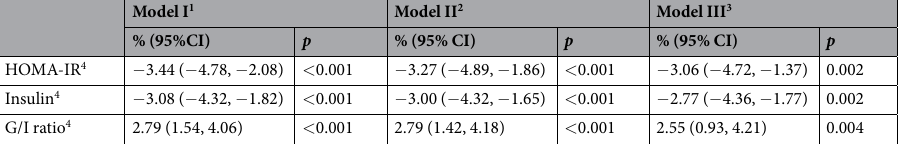
Table 2. Percentage Change (95%CI) in Insulin Resistance/Sensitivity Associated with a 25% Increase in Serum Folate Concentrations among U.S. Nondiabetic Adults, NHANES 2011–2012 1 Model I: Adjusted for age, gender (M/F), race/ethnicity (non-Hispanic White, Mexican American, non-Hispanic Black, other Hispanic, other Race), education (less than high school, high school, some college, college or above), BMI (normal weight, underweight, overweight, obese). 2 Model II: Adjusted for confounding factors in Model I plus smoking (nonsmoker, light smoker, heavy smoker), alcohol consumption (none, moderate, heavy), use of supplements (Y/N), and physical activity (low, moderate, high). 3 Model III: Adjusted for confounding factors in Model II plus total cholesterol, blood pressure, white blood cell count, vitamin B12. 4 Results were retransformed back to their original scale.